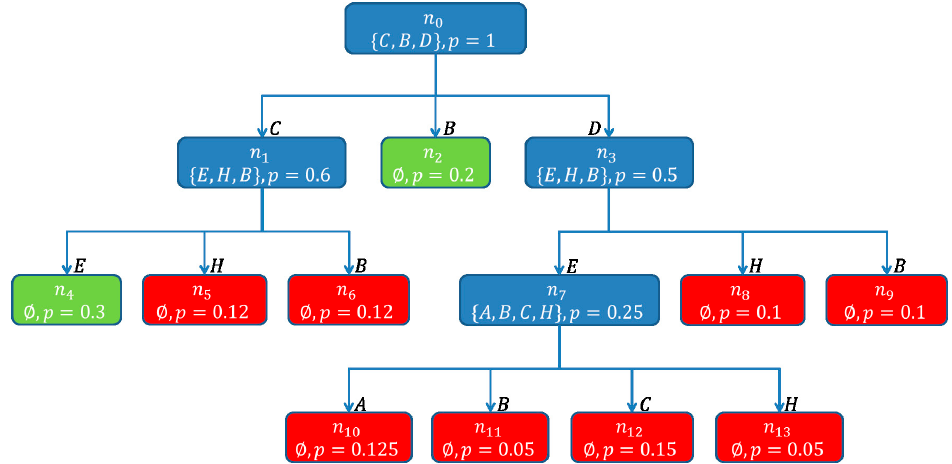
and 𝑛 (cid:2877) are closed and won’t be considered further (therefore depicted in red). are closed and won’t be considered further (therefore depicted in red). sets has finished.